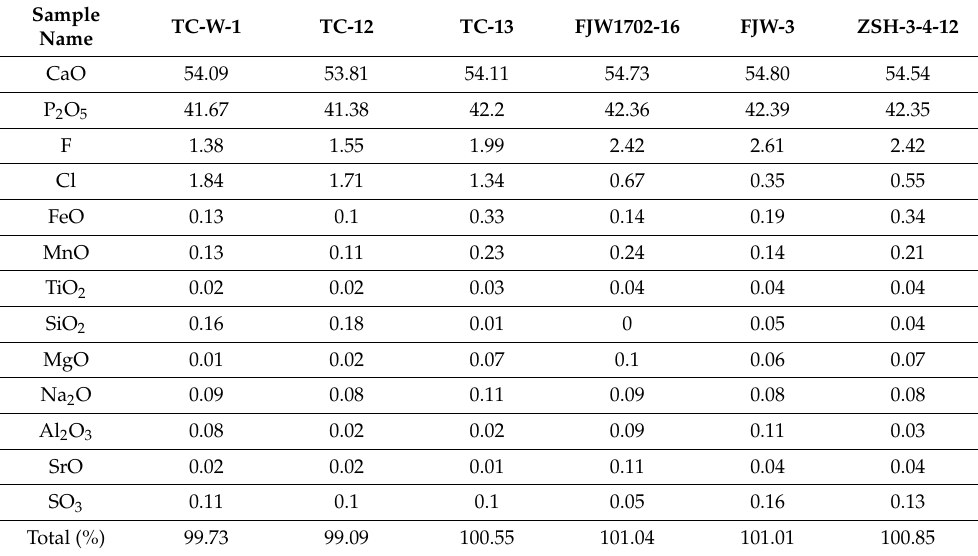
Table 3. Summary of the apatite major element contents of EPMA from six samples.